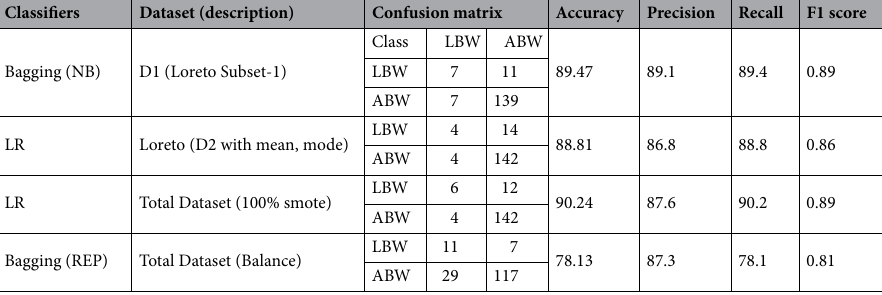
Table 5. Summary of the best classification